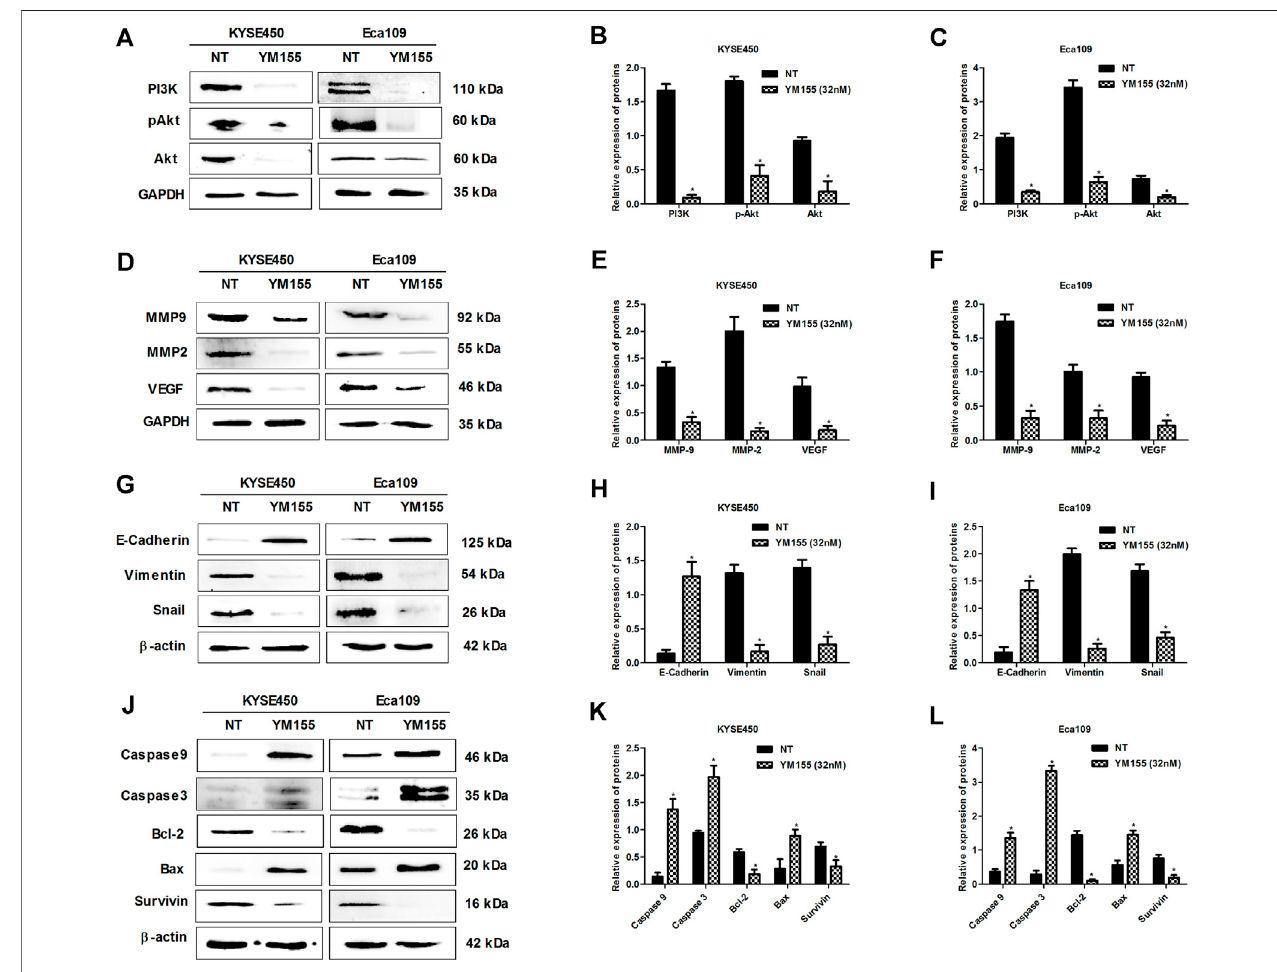
FIGURE 6 | Survivin inhibitor YM155 inhibits the expression of proliferation, apoptosis and metastasis-related proteins in ESCC cells. (A – C) Effects of survivin inhibitor YM155 on the expression of proliferation-related proteins in KYSE450 and Eca109 cells. (D – F) Effects of survivin inhibitor YM155 on the expression of MMP2, MMP9 and VEGF inKYSE450 and Eca109 cells. (G – I) Effects ofsurvivin inhibitor YM155 on theexpression ofEMTrelated proteins inKYSE450 and Eca109 cells. (J – L) Effects of survivin inhibitor YM155 on the expression of apoptosis-related proteins in KYSE450 and Eca109 cells. All data are expressed as mean ± standard deviation ( n = 3). * p < 0.05 vs. NT group. NT: No treatment. YM155 concentration: 32